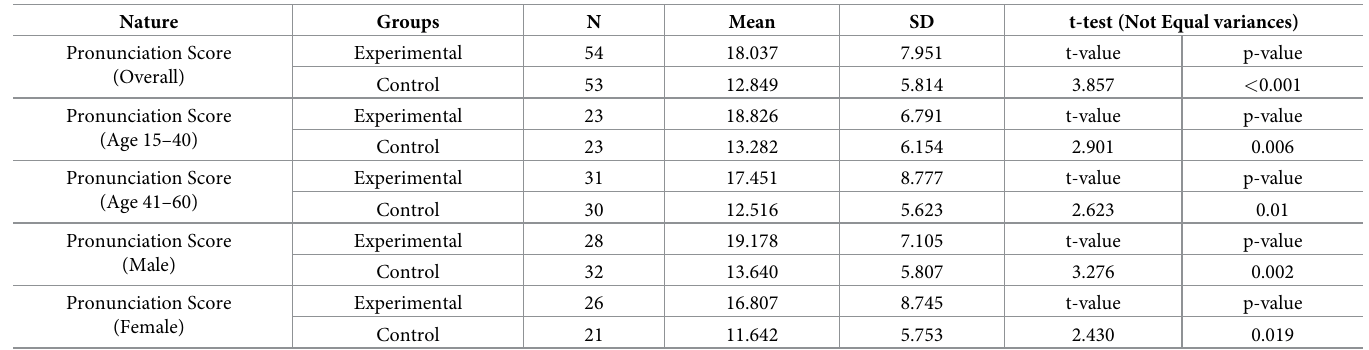
Table 5. Statistics of alphabet letter pronunciation scores of experimental and the